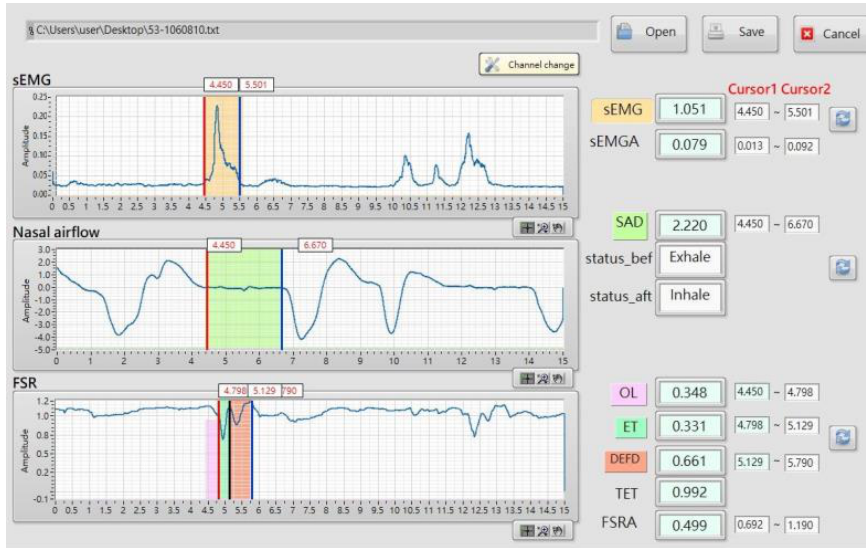
Figure 5. The program we developed from the algorithm in Algorithm 1.